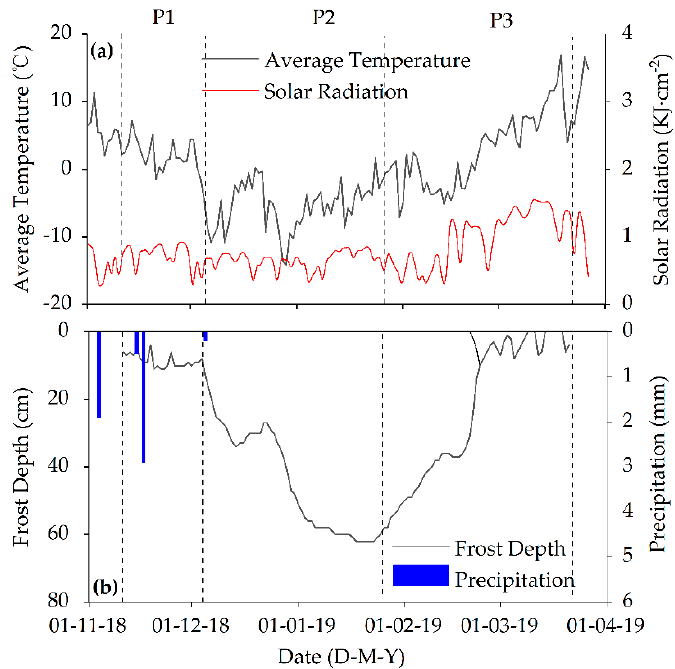
Figure 2. The variations of average daily temperature and solar radiation: ( a ) precipitation and ( b ) frost depth during the seasonal freeze–thaw period.